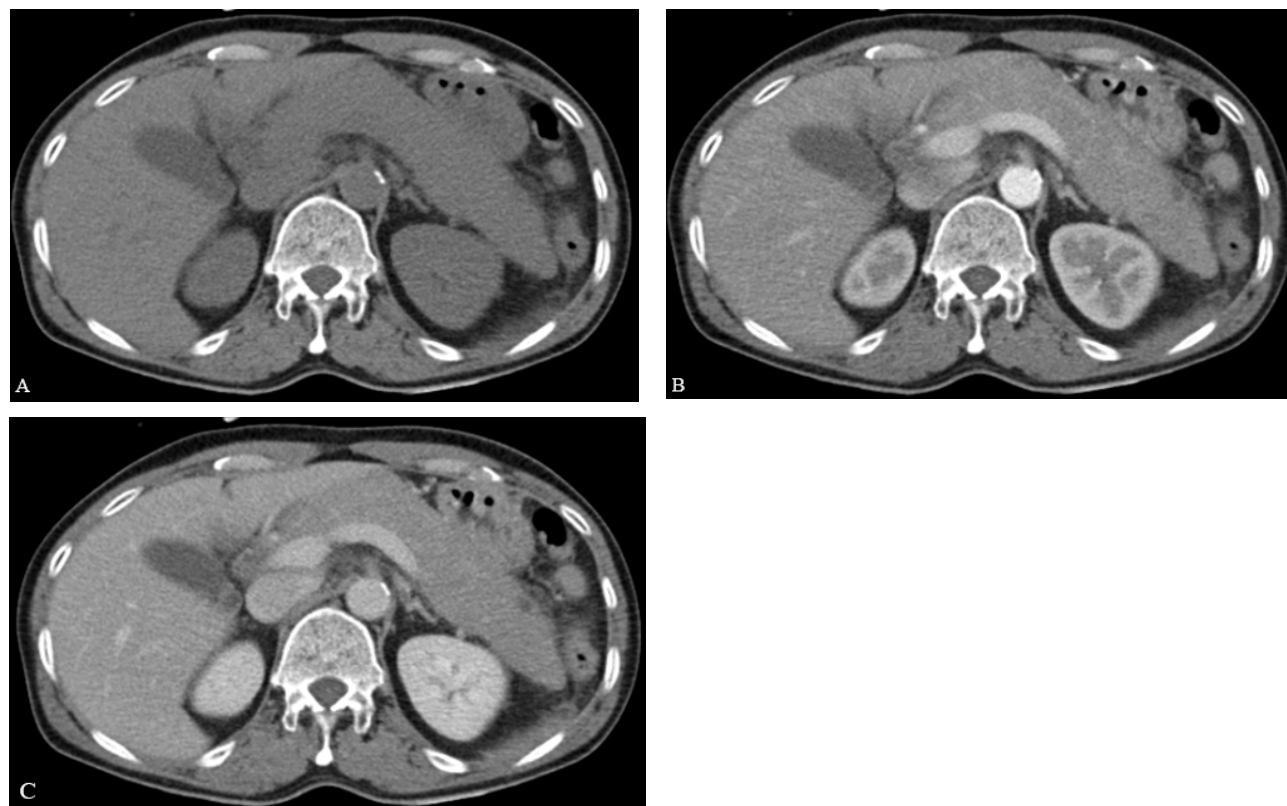
Figure 2. Pancreas finding during chemotherapy. Diffuse pancreas swelling was observed: ( A ) non- enhanced phase ( B ) arterial enhanced phase ( C ) venous enhanced phase.